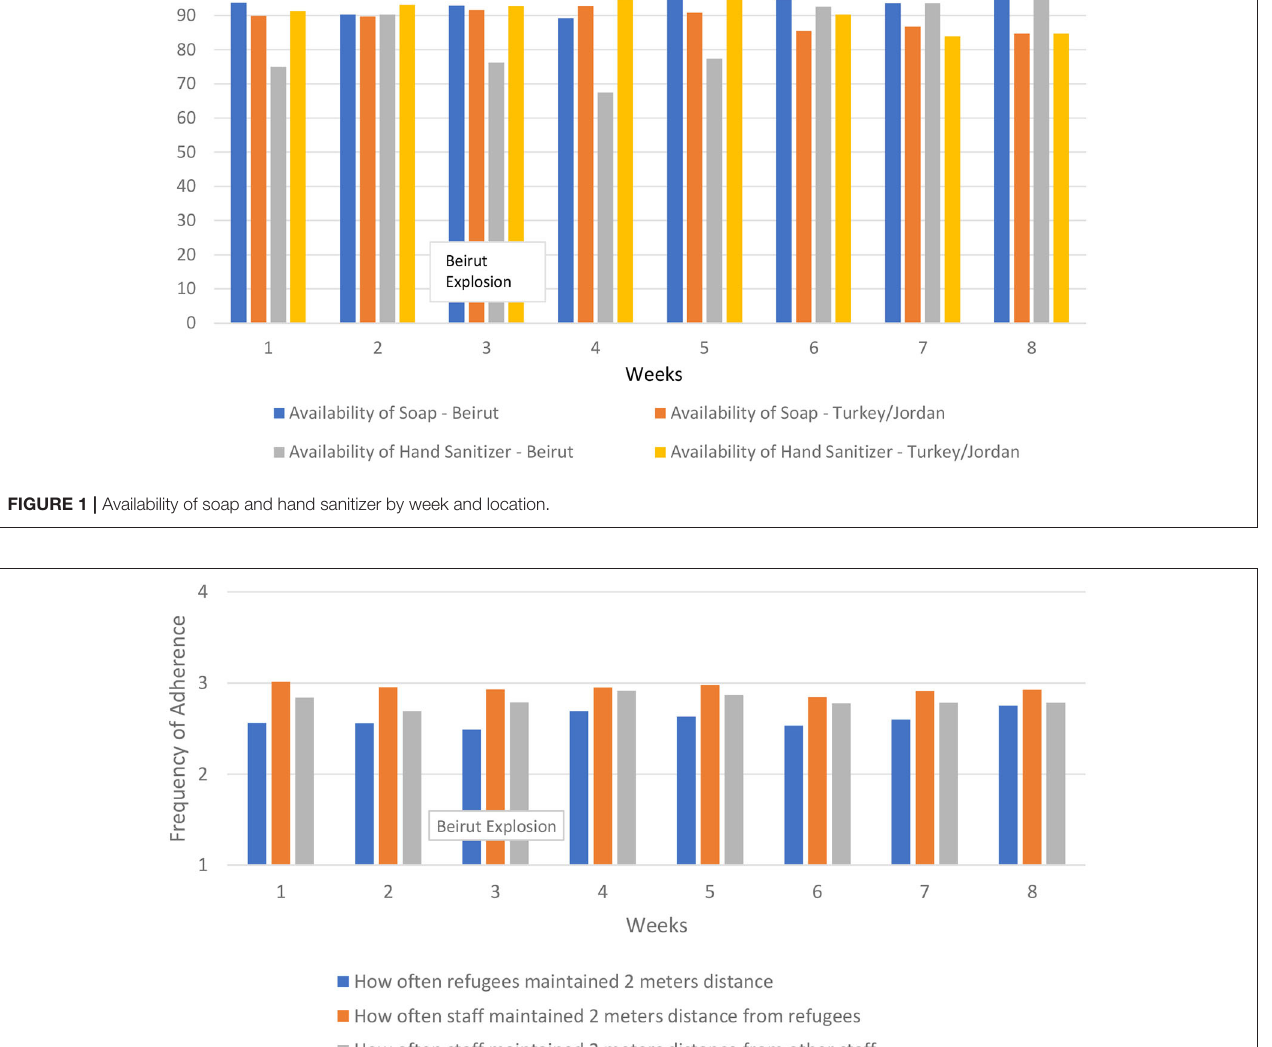
FIGURE 2 | Social distancing across